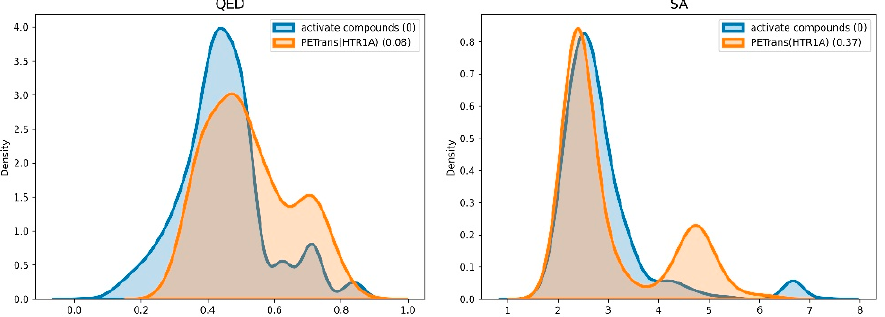
Figure A6. Distribution of the SA scores and the QED scores of the generated molecules for S1PR1.